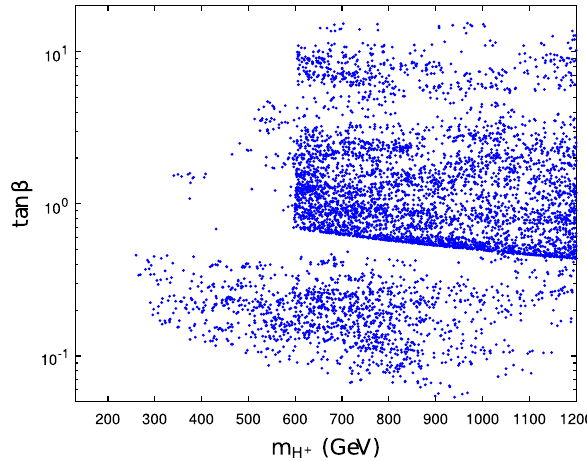
Fig. 1 v 2 /v 1 versus the charged-Higgs mass for the parameter-space points that survived all the theoretical and experimental